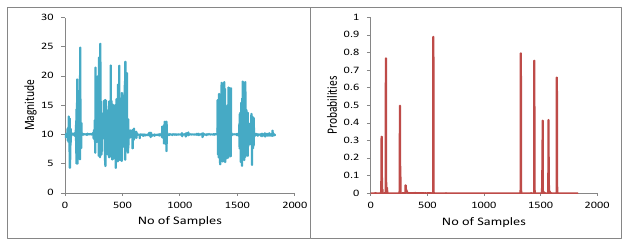
Figure 4: Magnitude of accelerometer signal (Left) and change- points with probabilities of that signal (Right) due to a person’s random movement patterns